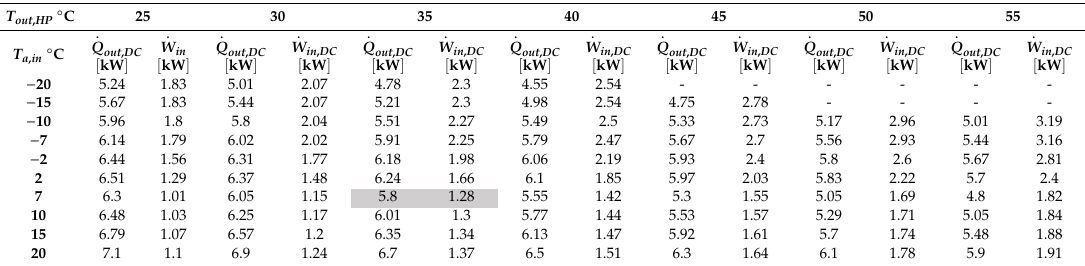
Table A1. Manufacturer’s Datasheet of the Considered Air-to-Water Heat Pump 1 . Grey Boxes Refer to Nominal